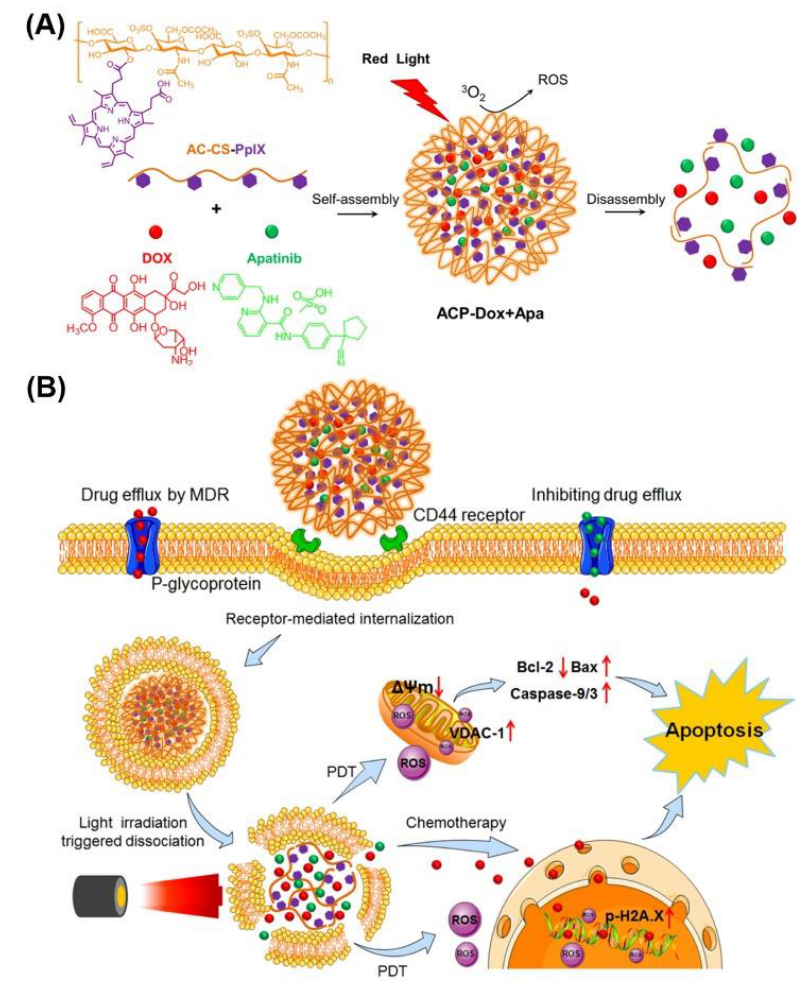
Figure 5. ( A ) Formation and decomposition of ACP-DOX + Apa micelles. ( B ) Underlying mechanism of combating the MDR (multidrug-resistant) using intelligent ACP-DOX + Apa micelles for promoting synergistic antitumor potency. Reproduced from [42] with permission, copyright 2018, American Chemical Society.